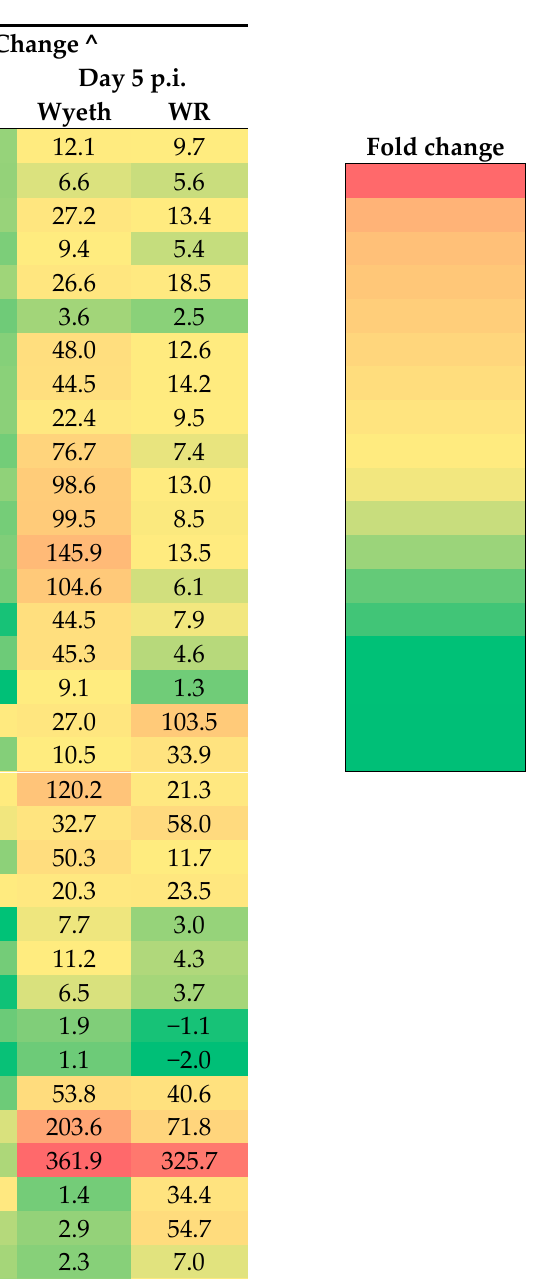
Table 3. Differential gene expression profile of immune response and tissue pathology 4 and 5 d.p.i. with VACV-Wyeth and VACV-WR.